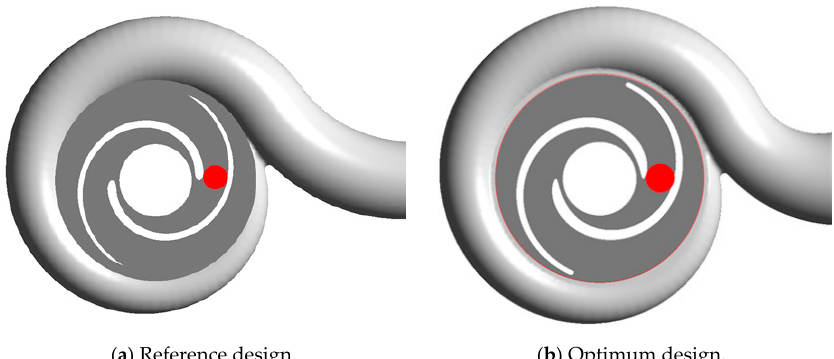
Figure 15. Comparison of three-dimensional (3D) geometries.